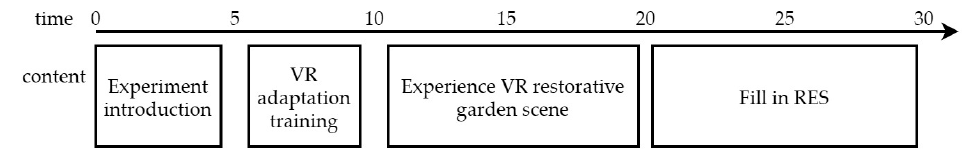
Figure 3. Experimental procedure. VR: Virtual Reality, RES: Restorative Environmental